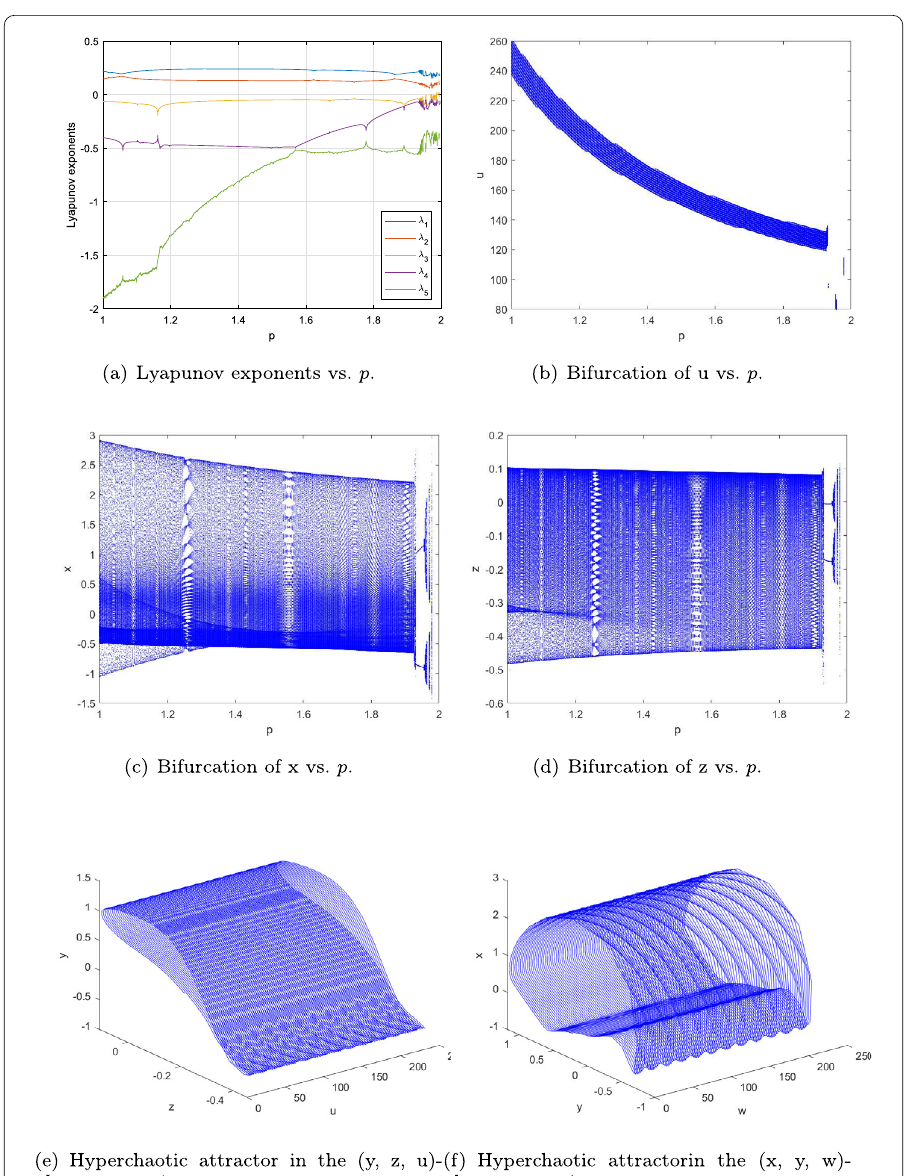
Figure 5 Complex behavior of system (16) with p